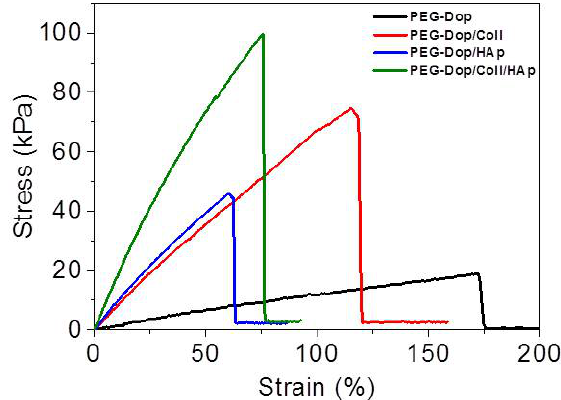
Figure 2. Representative tensile curves of PEG-Dop, PEG-Dop/Coll, composite hydrogel PEG-Dop/HAp, and composite mixture PEG-Dop/Coll/HAp. Concentration of the different components is as follows: